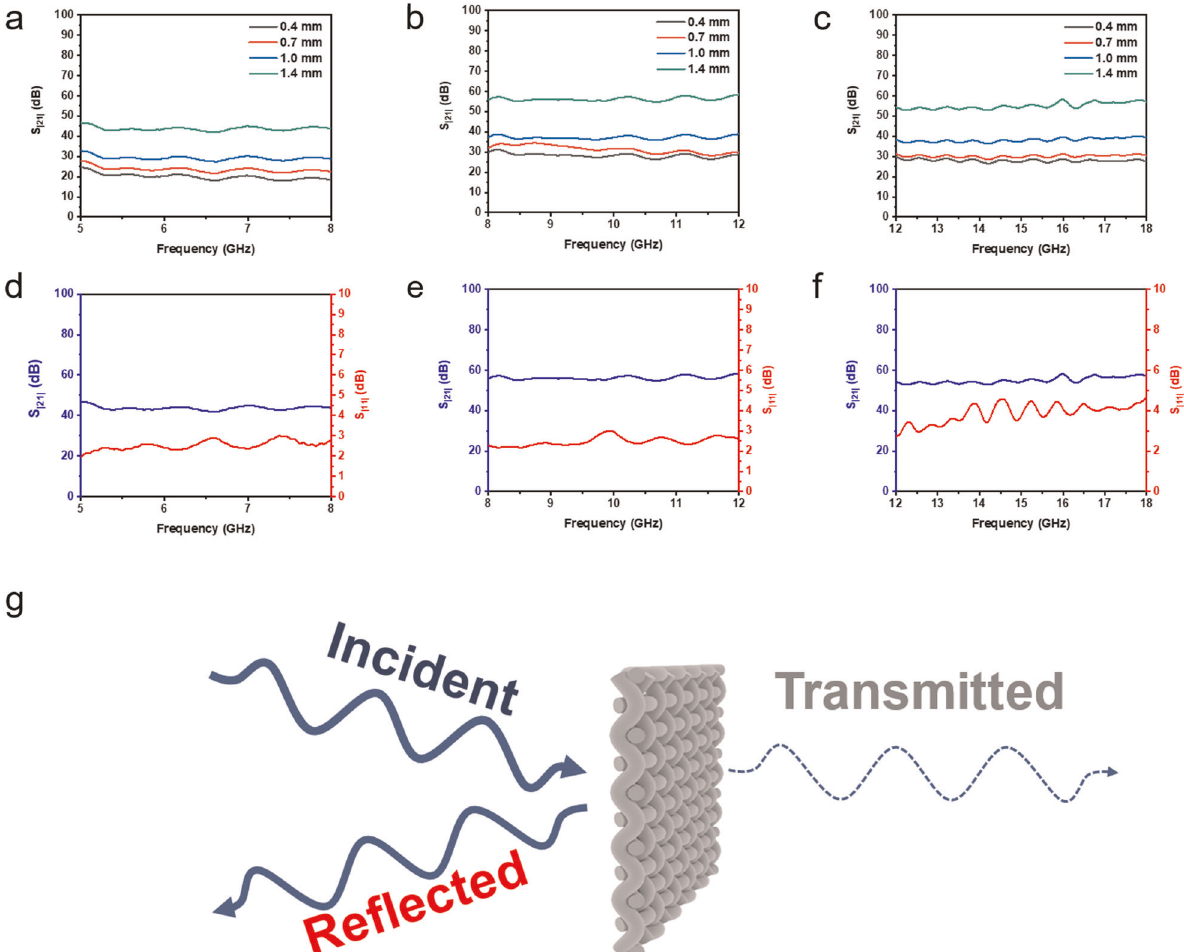
Fig. 3 Effectiveness of the EMI shielding and AgNWs/PVB textile schematic. a – c EMI SE AgNWs/PVB textile of various thickness in 5 – 8, 8 – 12, and 12 – 18 GHz frequency ranges, including the S-parameter result of S 21 . d – f EMI SE of 1.4 mm thick AgNWs/PVB textile in 5 – 8, 8 – 12, and 12 – 18 GHz frequency ranges, including the S-parameter result of S 21 (blue) and S 11 (red). g EMI shielding schematic of AgNWs/PVB textile including the incident, re fl ected and transmitted electromagnetic fi